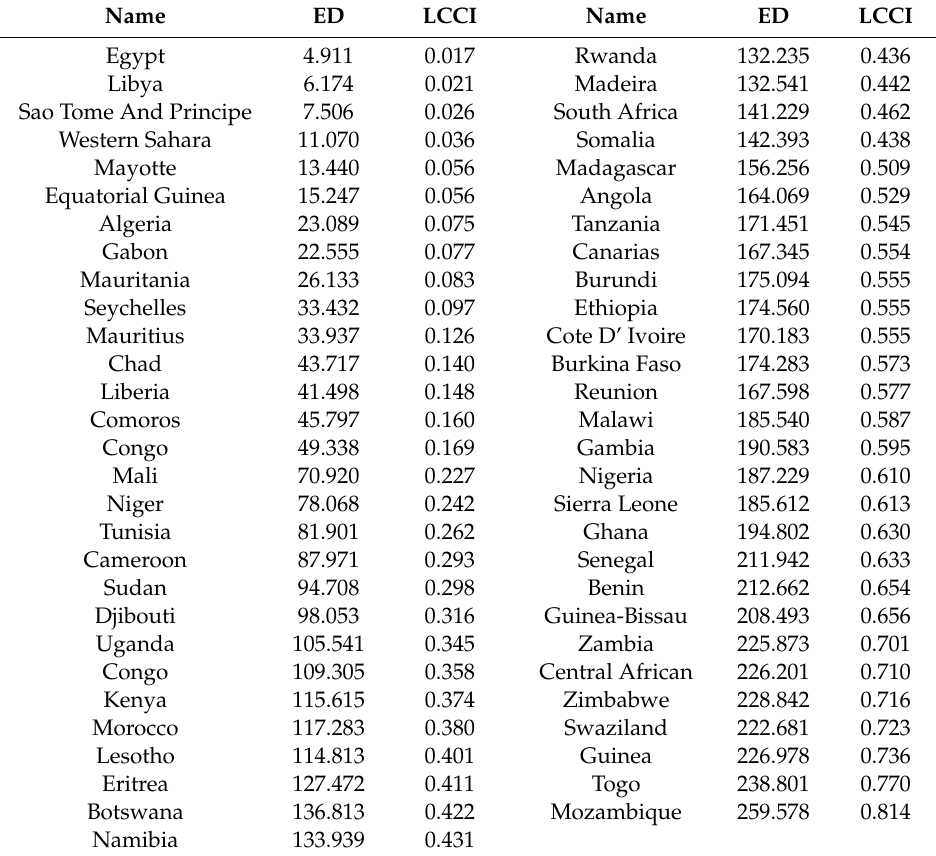
Table 2. Land cover heterogeneity of di ff erent countries measured by LCCI and ED.